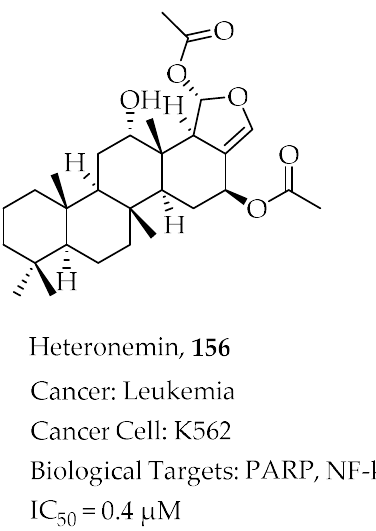
Figure 37. Structures of cyclic steroidal glycosides Luzonicoside A, Luzonicoside D, and a steroidal epoxide Aragusterol A with a summary of their biological activity towards selected cancer targets.